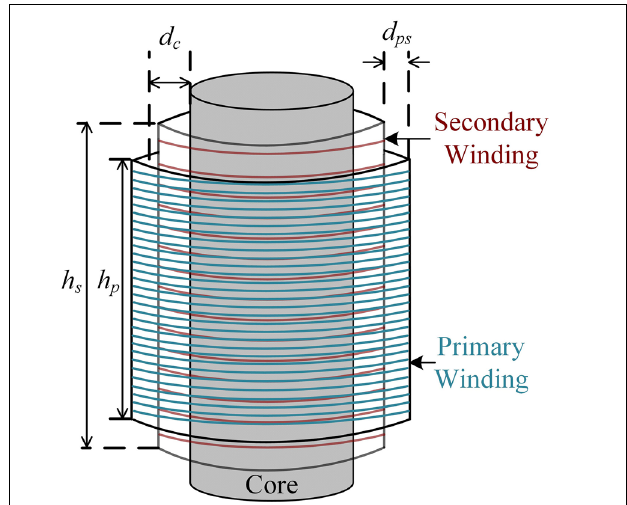
FIGURE 1 | A generic transformer core and its